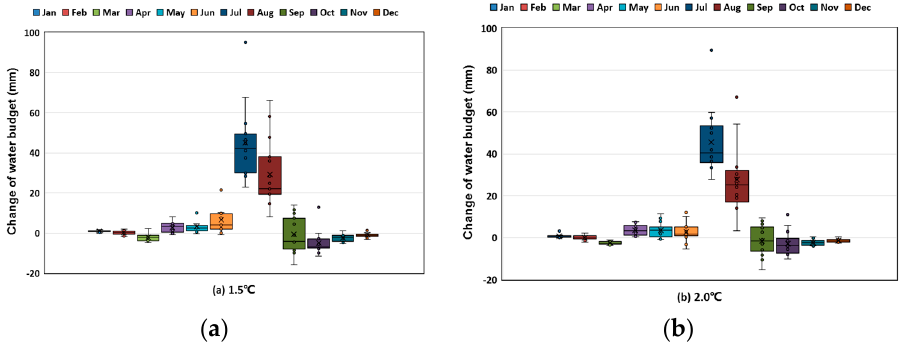
Figure 13. Monthly water budget under global warming scenarios ( a ) 1.5 °C; ( b ) 2.0 °C.